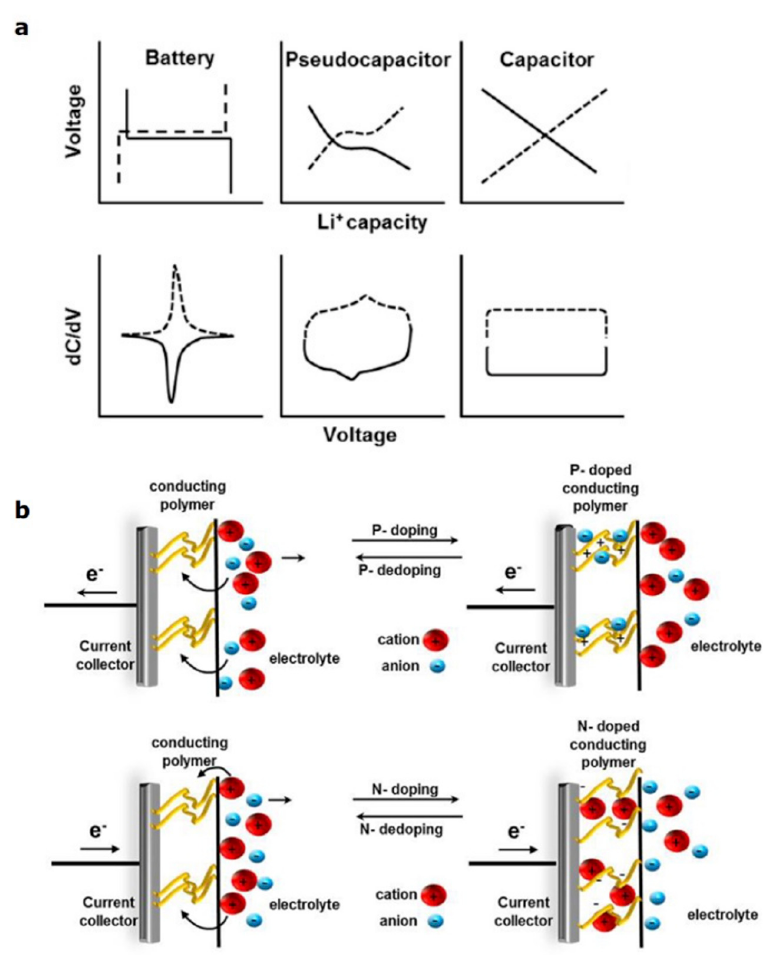
Figure 2. ( a ) Potential and differential capacity scheme for the three basic charge/discharge mecha- nisms. ( b ) charge/discharge processes for p-type and n-type doping in conducting polymers.